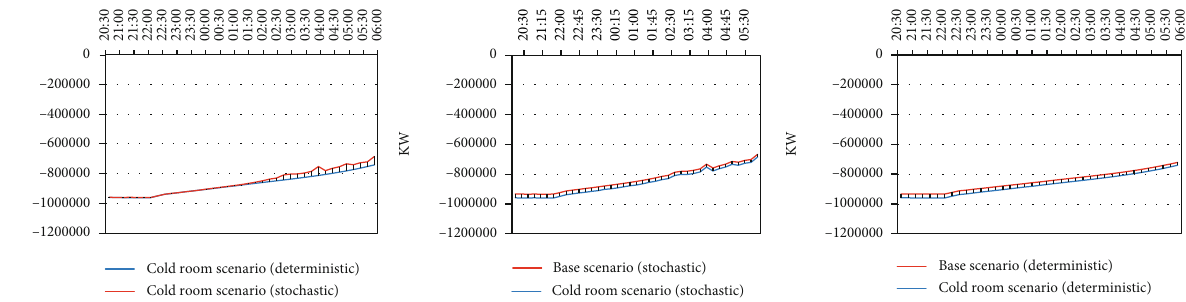
Figure 28: Di ff erent modes in the cold room scenario (night).